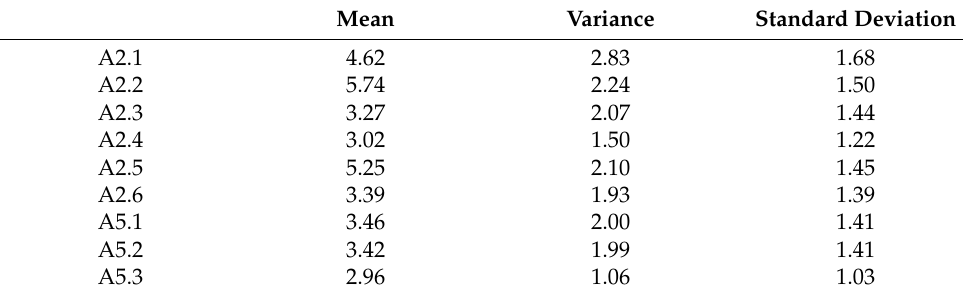
Table 10. Descriptive statistics for IEQ responses in the Richard Crossman